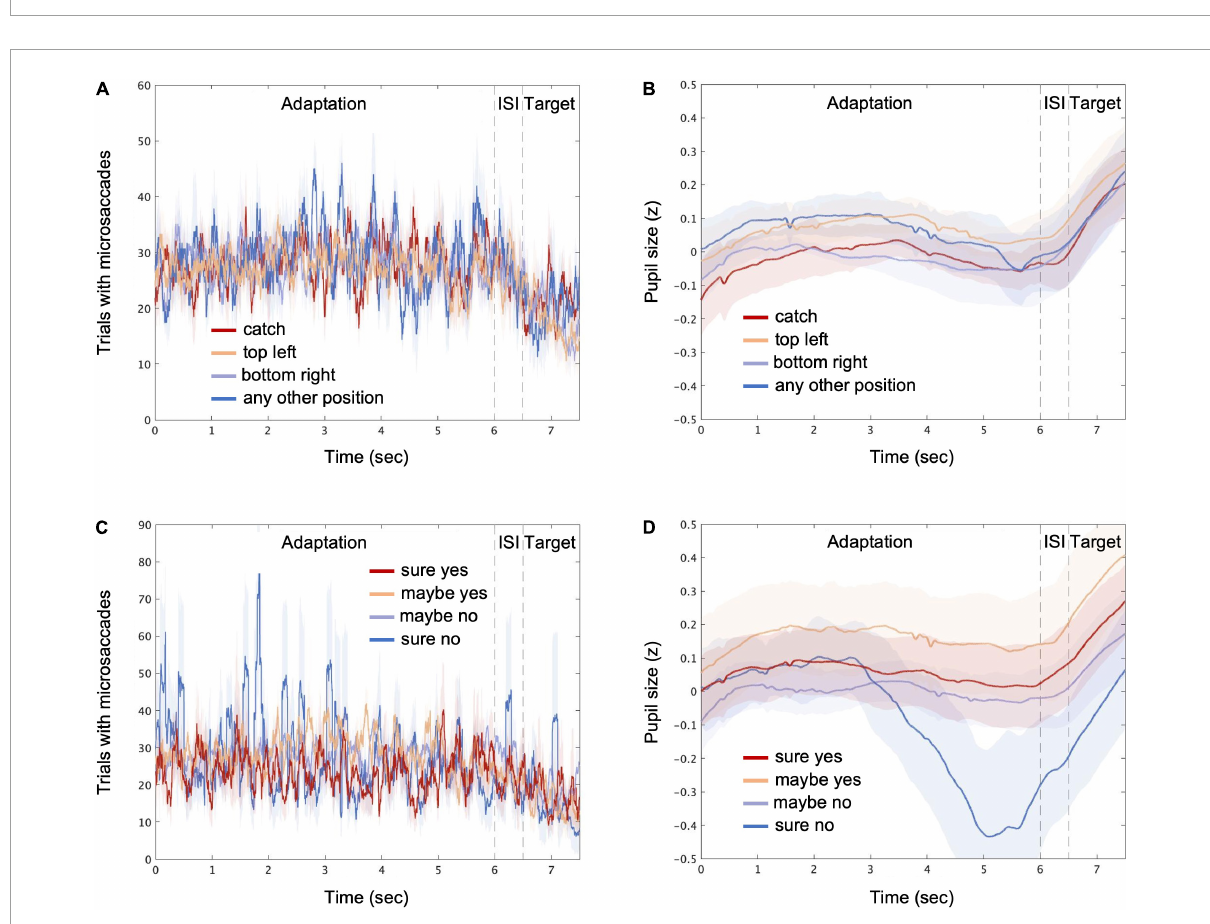
FIGURE3 Microsaccades and pupil size over time. The average count of trials with microsaccades detected (see “Materials and methods”) is shown for stimulus conditions [“catch,” “top left,” “bottom right,” and “any other position”; (A) ] and for response conditions [“sure yes,” “maybe yes,” “maybe no,” and “sure no”; (C) ], respectively. The average pupil size is shown for different stimulus (B) and response (D) conditions, respectively. The time points consist of the adaptation, inter-stimulus interval (ISI), and target periods. The shaded areas represent ± 1 SE across all